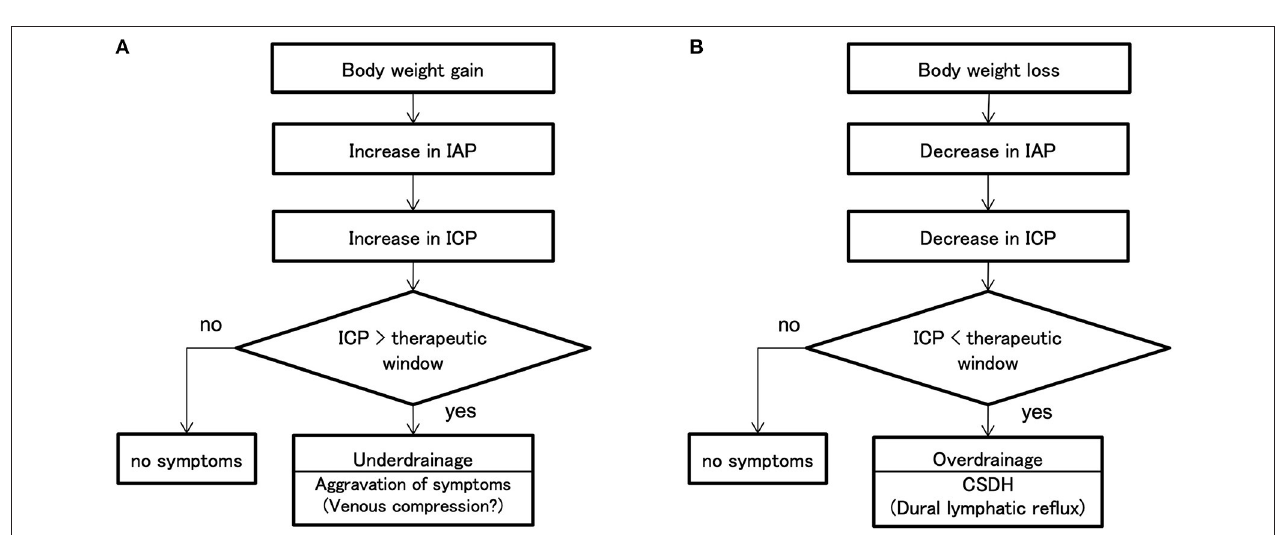
FIGURE 7 | Mechanisms of shunt malfunction associated with weight change. (A) Weight gain increases the IAP. In the patients with shunted hydrocephalus, ICP is linked to IAP, so weight gain also increases ICP. Symptoms worsen when the patient’s ICP exceeds the therapeutic window. Neurological symptoms with underdrainage are more likely to be cerebral circulatory disturbances due to venous compression because of the immediate improvement. (B) Weight loss decreases IAP; ICP linked to IAP decreases simultaneously; if ICP falls below the therapeutic window, a CSDH occurs. If the patient’s ICP falls below the therapeutic window, CSDH develops. In this study, we showed that at the time of overdrainage, the subdural space has a significant negative pressure of − 18mm Hg against intradural veins and lymphatic vessels. Since there are few valves in the lymphatic vessels of convexity dura, the backflow of lymphatic fluid in the lymphatic vessels may lead to lymphatic effusion in the subdural space. ICP, intracranial pressure; IAP, intra-abdominal pressure; CSDH, chronic subdural hematoma.